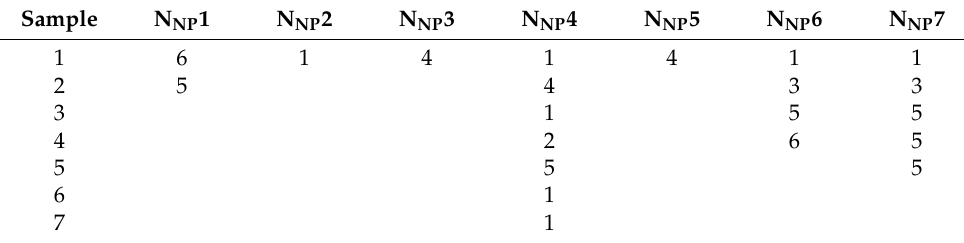
Table 4. Incorrect detection results of the experimental